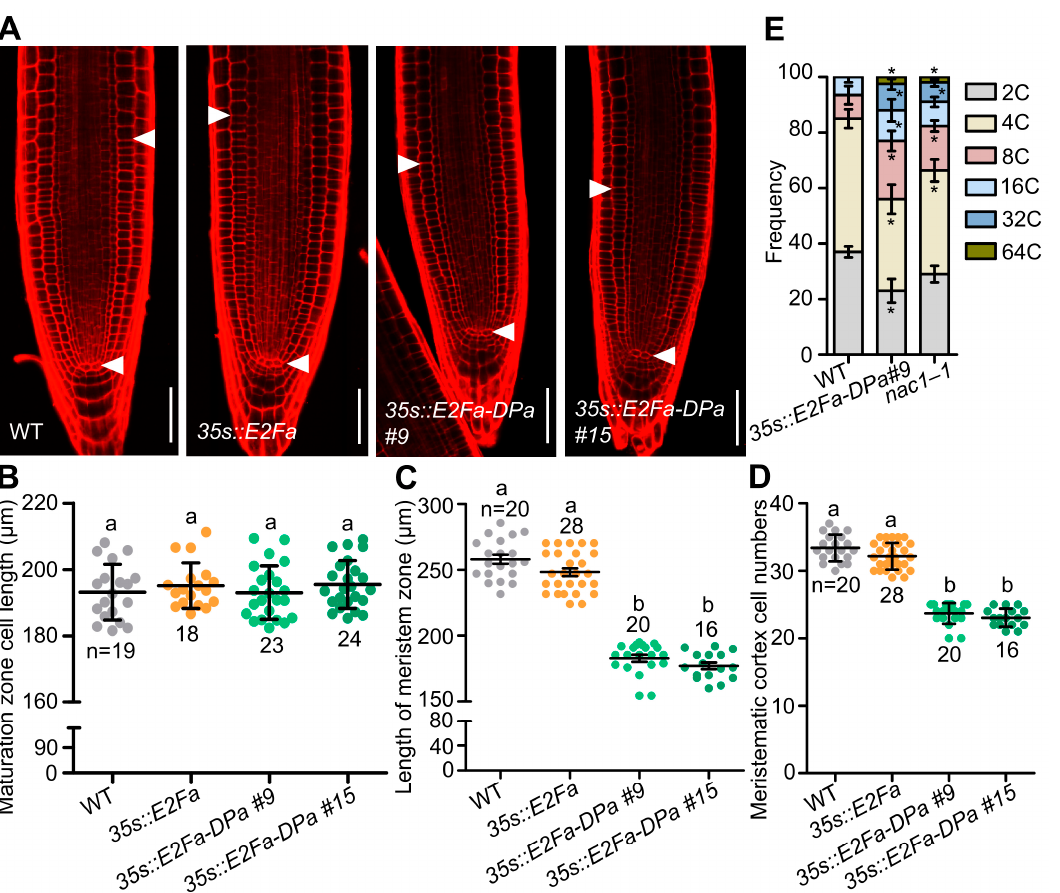
Figure 5. Overexpression E2Fa-Dpa complex affects root length by promoting endoreduplication. ( A ) Confocal images of root tips of WT, 35s::E2Fa , and two independent overexpression transgenic lines of E2Fa-DPa . The seedlings were used at 5 dpg for imaging. White arrows indicate the boundary between root meristem and transition zones. Scale bars represent 50 μ m. ( B ) Root cortical cell length in the maturation zone of 5 dpg seedlings as shown in ( A ). ( C ) Length of meristem zone of 5 dpg seedlings as shown in ( A ). ( D ) Cell numbers in the proliferation domain of 5 dpg seedlings as shown in ( A ). ( E ) Distribution of nuclear ploidy in the root meristem cells of WT, 35s::E2Fa-DPa #9 , and nac1–1 , using flow cytometry at 4 dpg. Two independent experiments were performed, and representative results are presented (Student’s t test, * p < 0.05). Data information: in ( B – D ), data represent mean ± SD, n denotes the total number of scored samples. Individual values (black dots) are shown. Different lowercase letters indicate significant differences by one-way ANOVA followed by Tukey’s multiple comparison test ( p < 0.05).